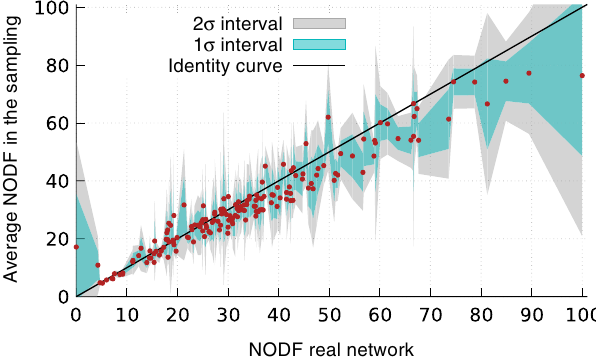
FIG. 10. Comparison between the real measure of the NODF and the average computed over the sampling formed by 10 4 networks for the 167 networks of our study.